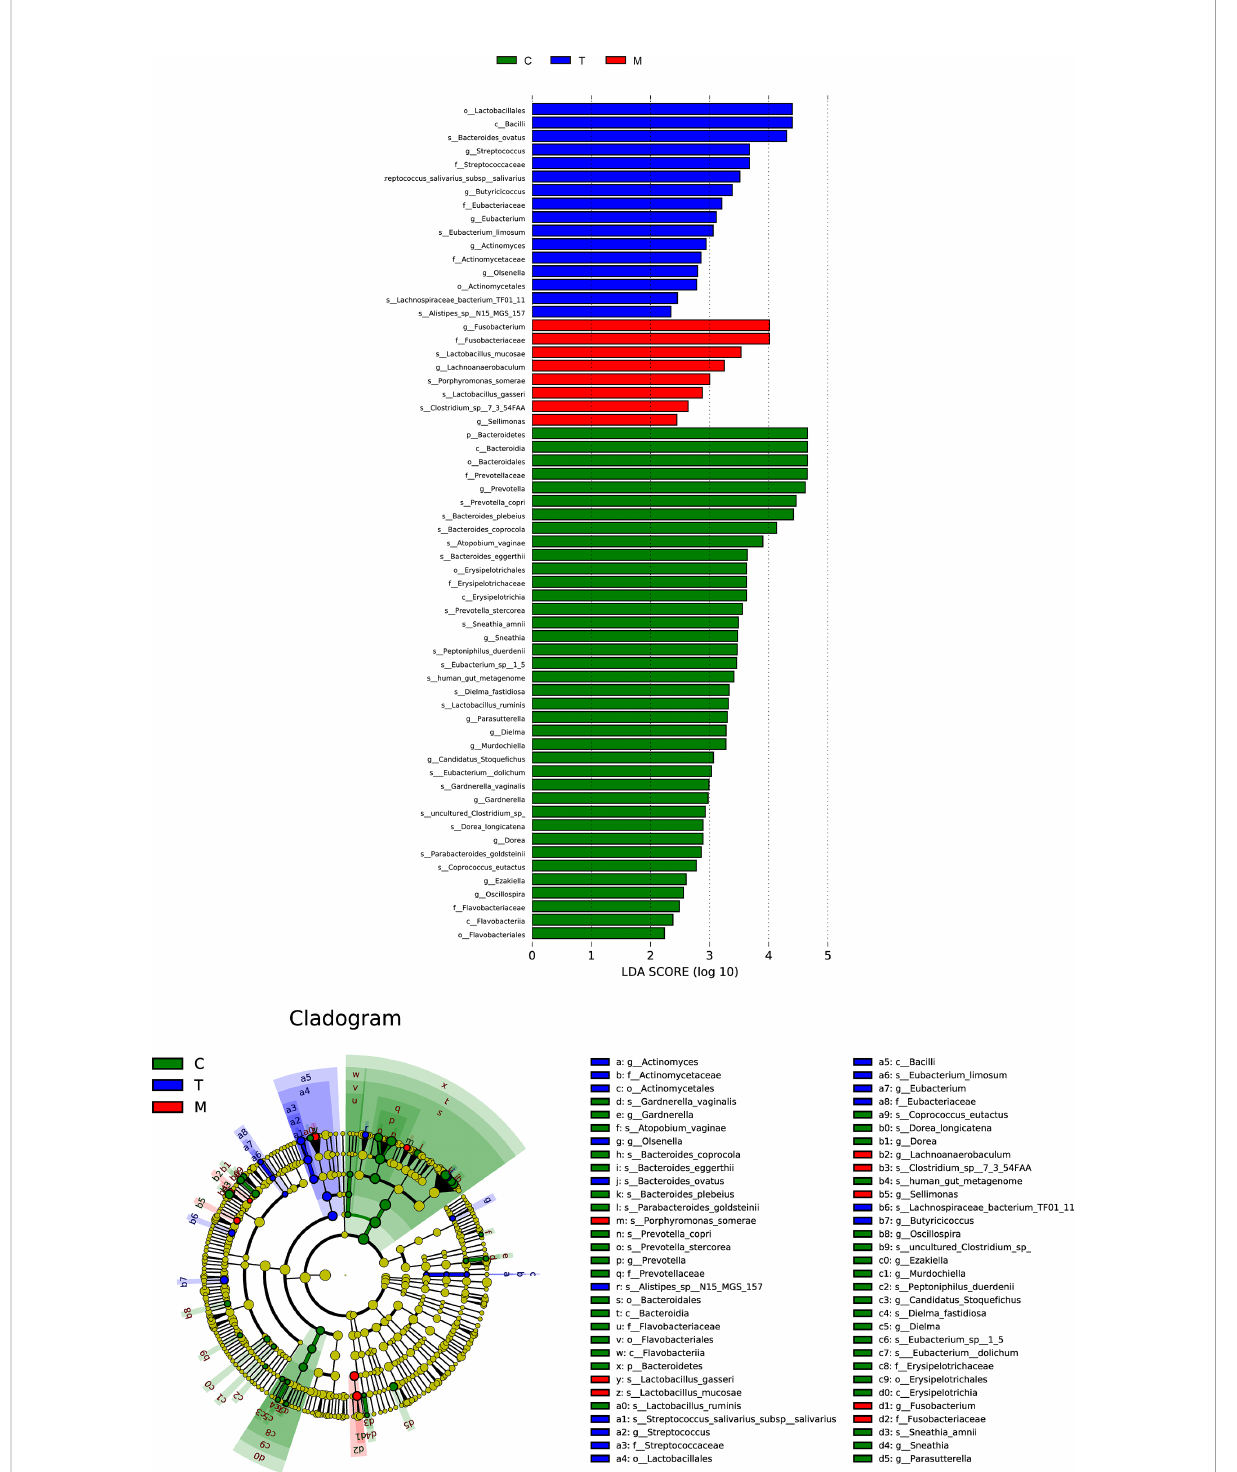
FIGURE 5 Histogram and cladogram of Linear discriminant analysis effect size (LEfSe) analysis among the general control group and the experimental